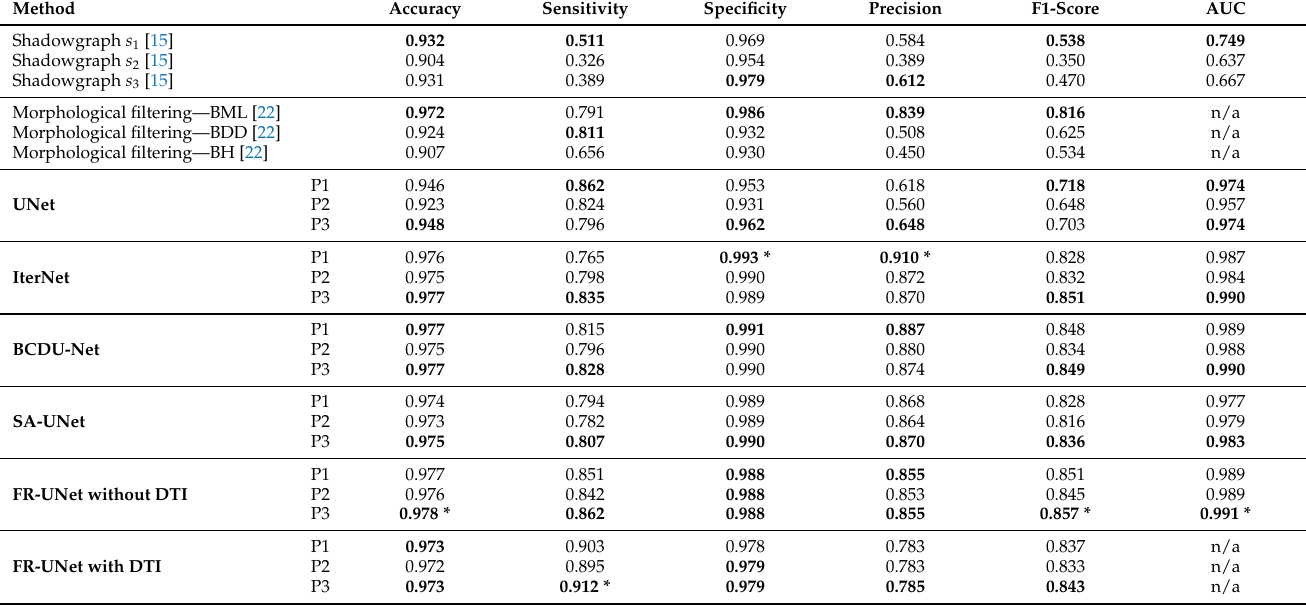
Table 2. Comparison of neural network